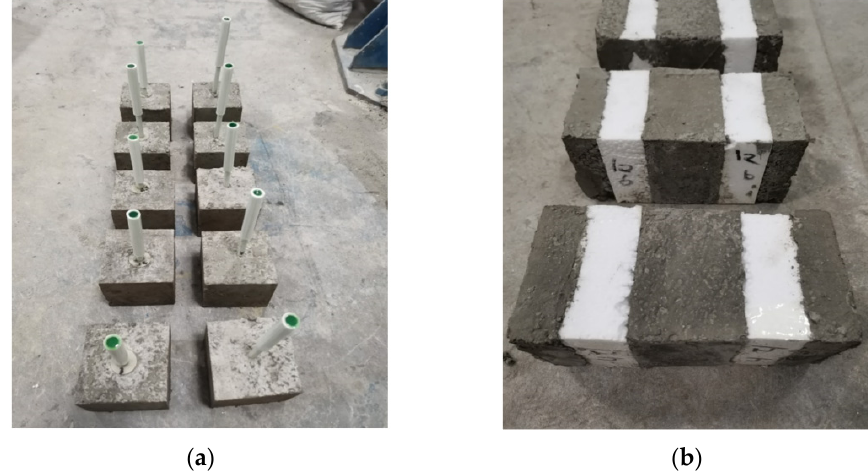
Figure 1. Physical image and dimensions of the connection parts (Unit: mm): ( a ) Claw connectors; ( b ) Rod connectors.